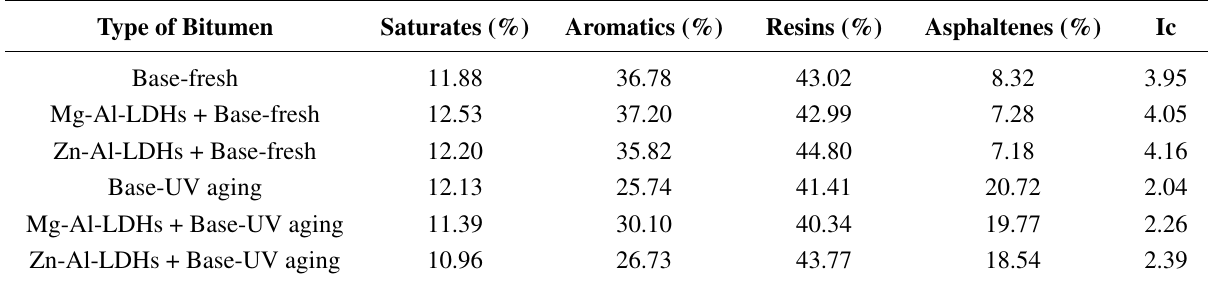
Table 2. Chemical compositions of base and modified bitumens before and after UV aging.